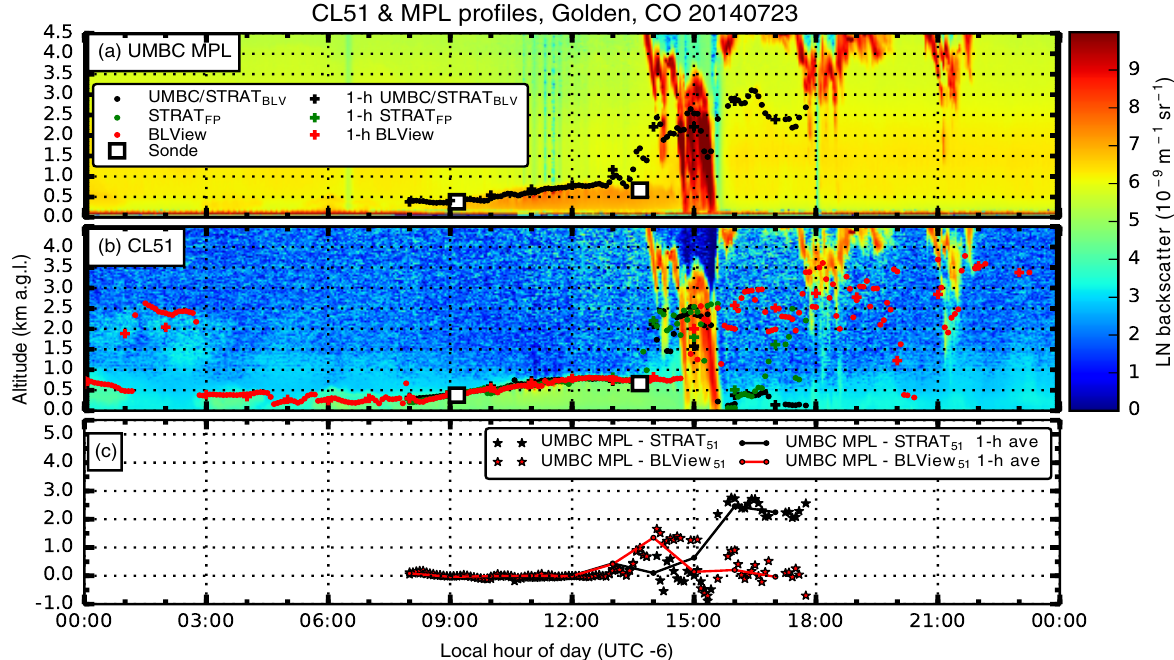
Figure 16. Comparison of the CL51 and UMBC MPL profiles for 23 and 27 July 2014 at the Golden, Colorado site.